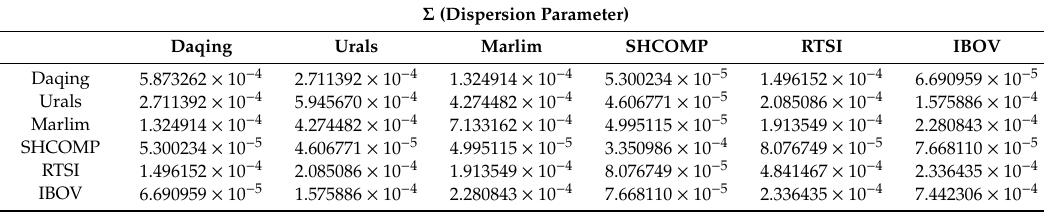
Table A7. MNIG Dispersion parameter Σ for Vector 2: Daqing, Urals, Marlim, SHCOMP, RTSI, IBOV.